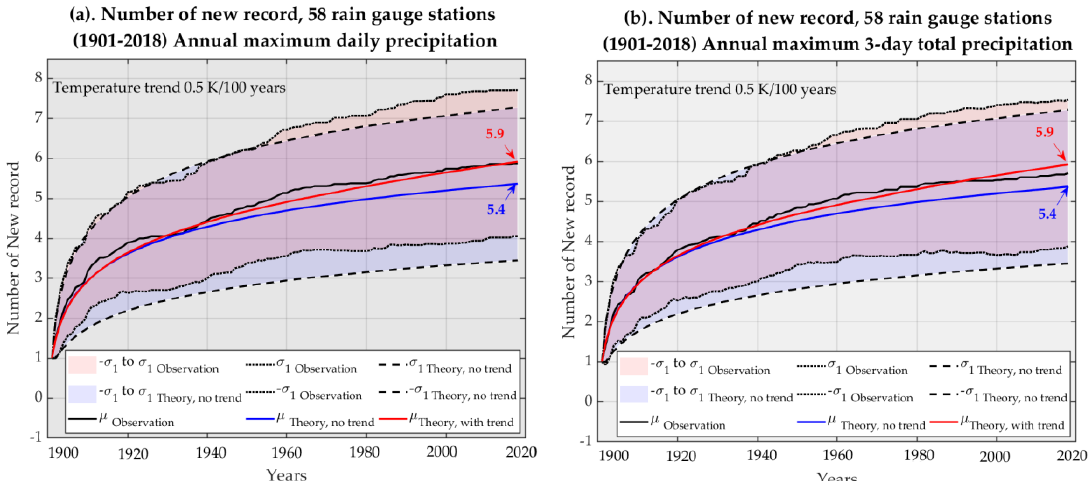
Figure 4. Comparison of the theoretical values without the temperature trend (blue solid line) with the average values of new records among the 58 rain gauges in Japan (black solid line) for annual maximum ( a ) daily and ( b ) 3-day total precipitation. The standard deviation is plotted with the black dashed lines. The theoretical values incorporating the temperature trend are plotted with the red solid